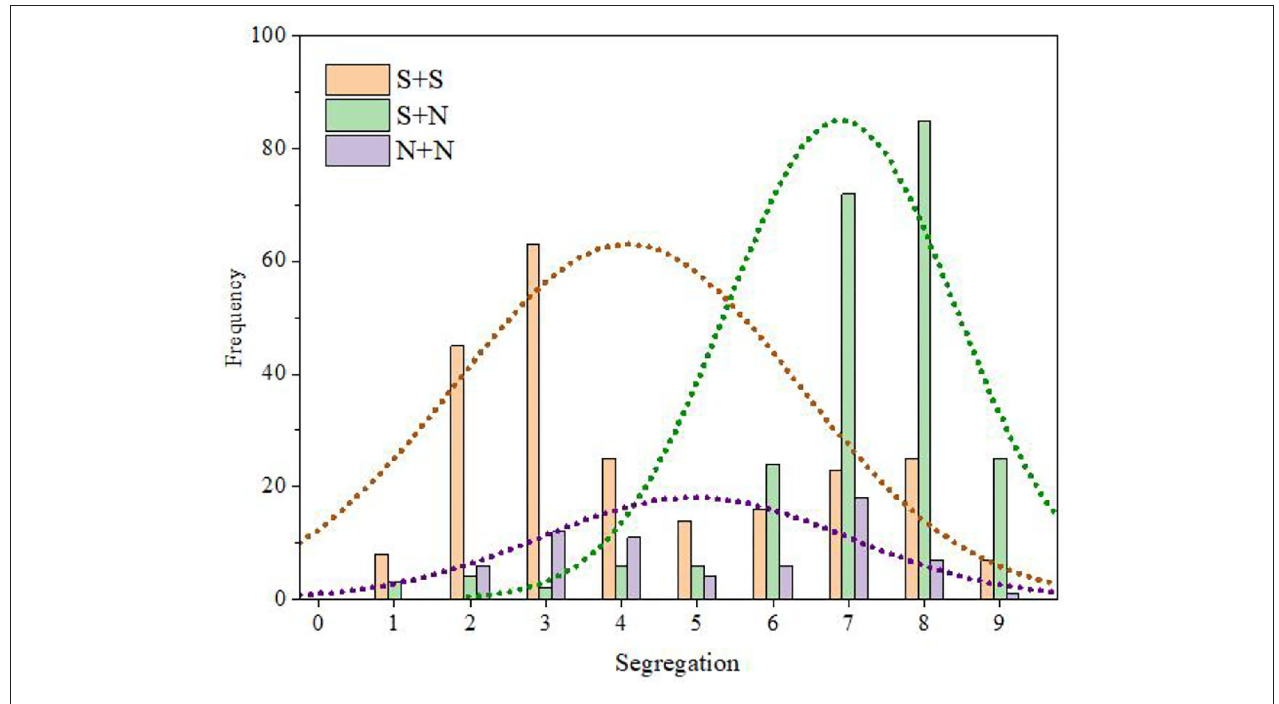
FIGURE 10 | Distribution statistical histogram of segregation category.